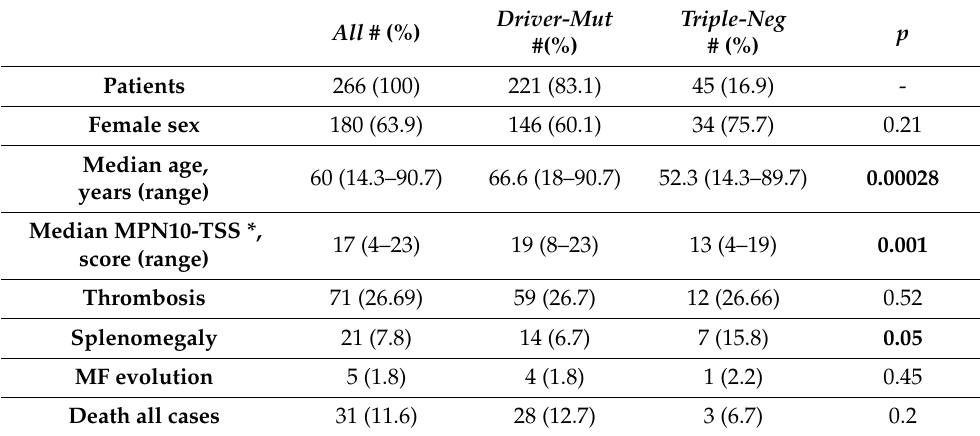
Table 1. Main results of the study described for all ET patients, driver-mutated and triple-negative subgroups. #, absolute number of cases; %, percentage. * MPN10-TSS: Myeloproliferative Neoplasms 10—Total Symptom Score. For the MPN10 item, data were available for 148 patients (116 driver-mut and 32 triple-neg).